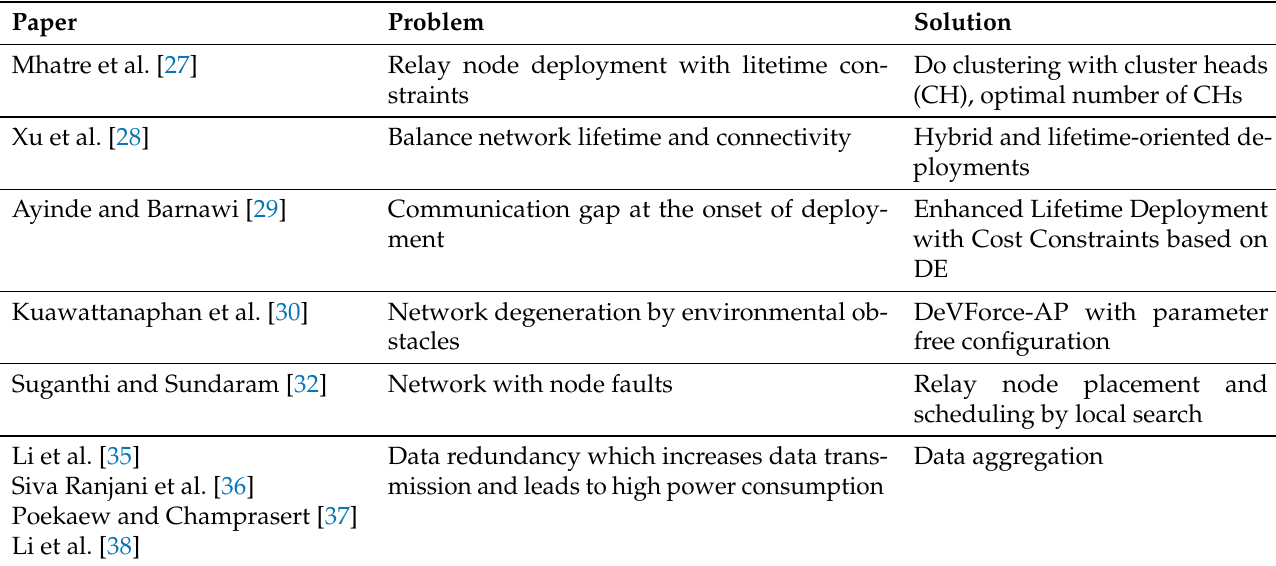
Figure 6. Ad hoc network with cluster head deployment (adapted from [39]). Table 3. Summary of ad hoc topology problems and